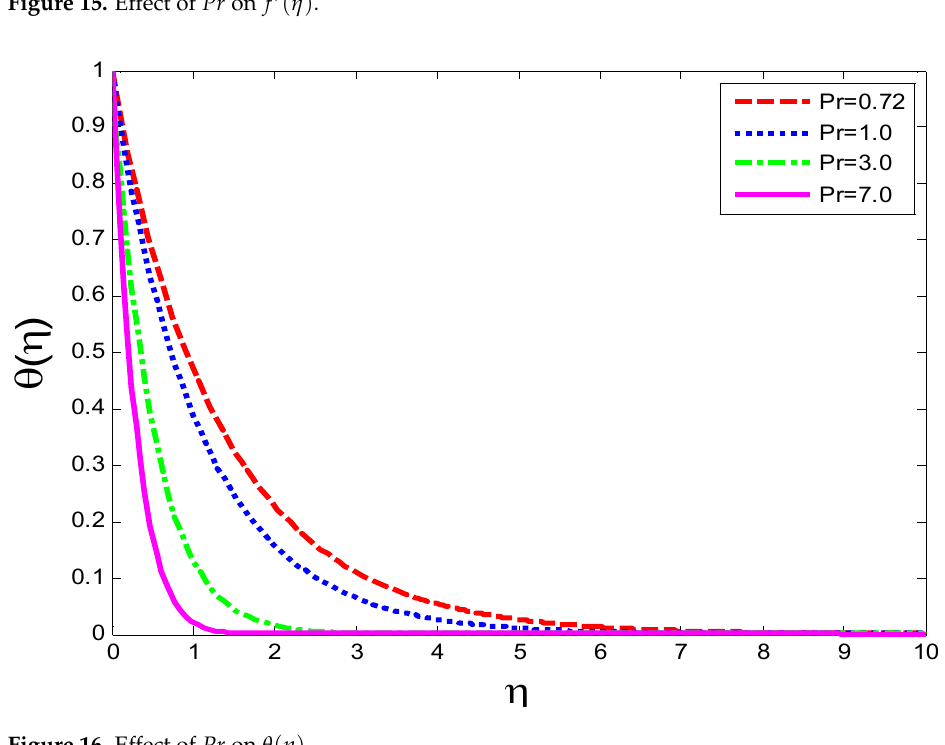
Figure 16. Effect of Pr on θ ( η )